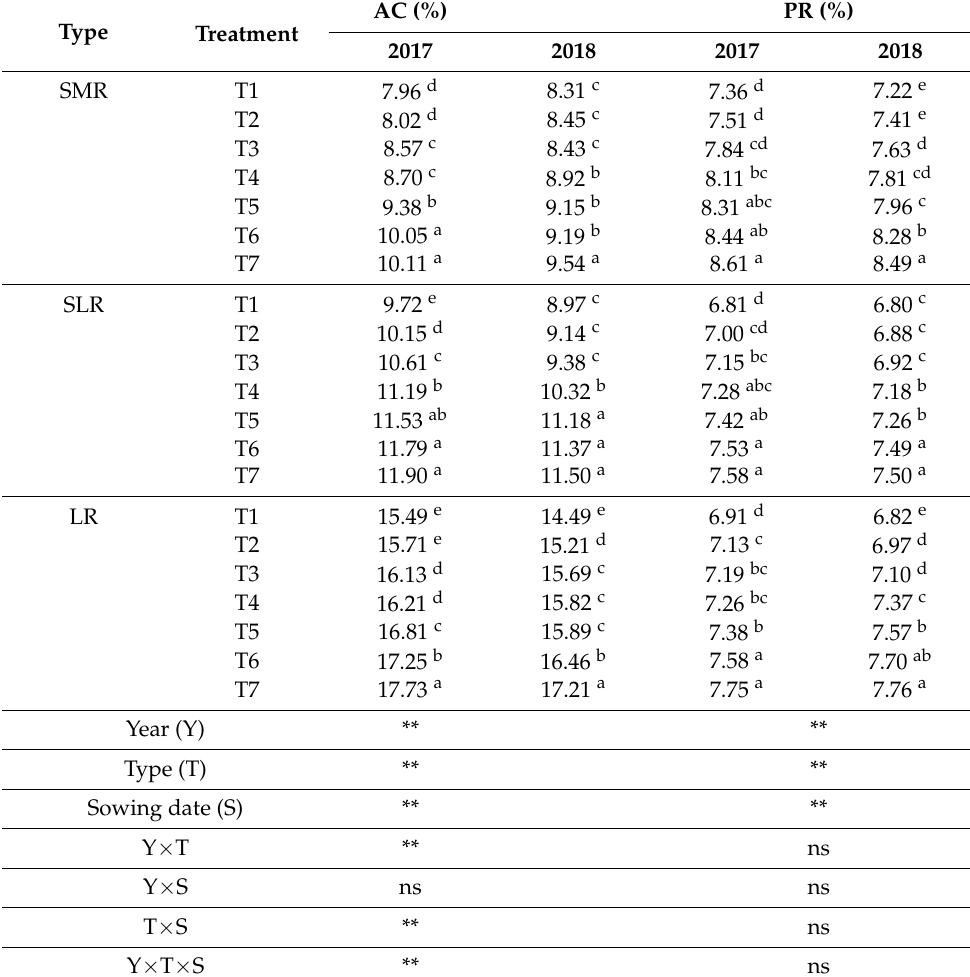
Table 3. Effect of T and R on AC and PR in rice 1